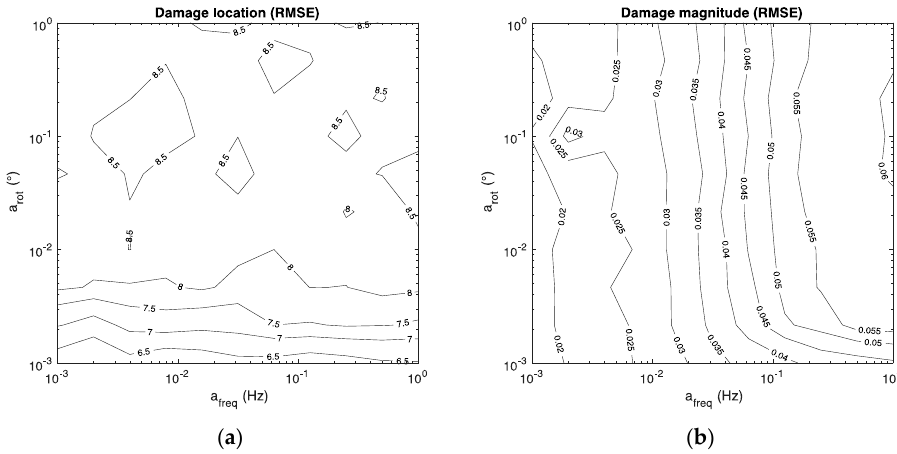
Figure 6. Root-mean-squared errors for the accuracy of the frequency in the range 0.001 Hz to 1 Hz and the accuracy of the rotation in the range 0.001° to 1°. In ( a ) the root-mean-squared error, in meters, related to damage location is proposed. In ( b ) the root-mean-squared error related to damage magnitude is reported.